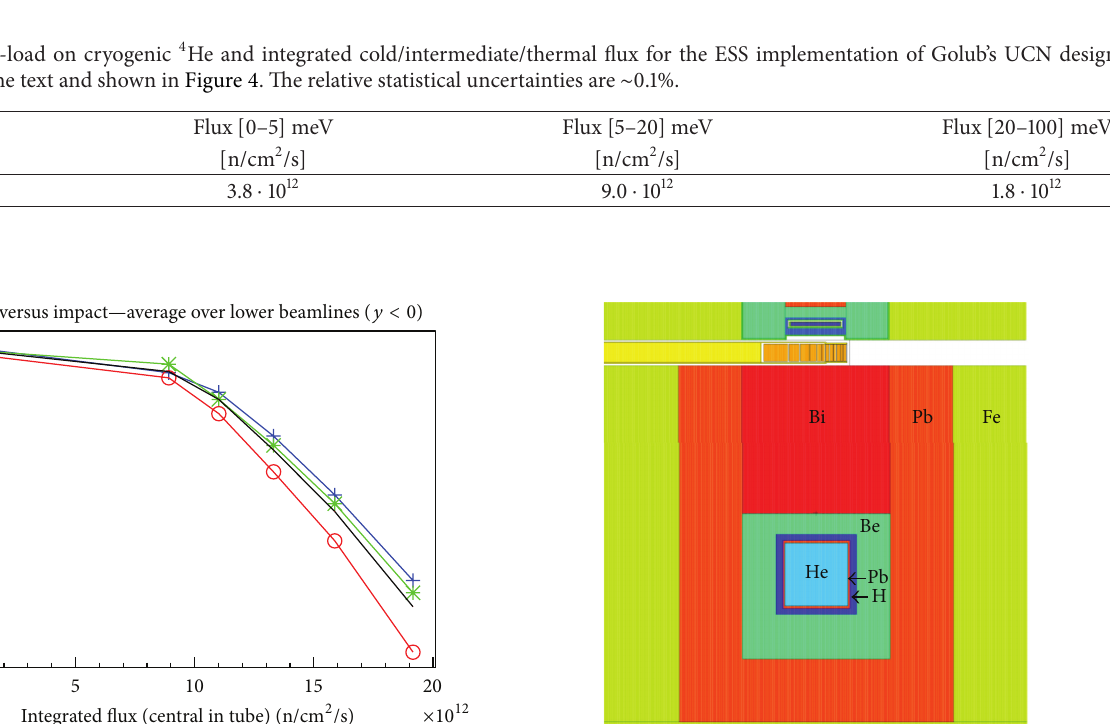
Figure 4: Assuming that all cold/thermal neutron scattering instru- ments can be served by a single flat moderator on top of the target wheel, a large 4 He source is installed below the